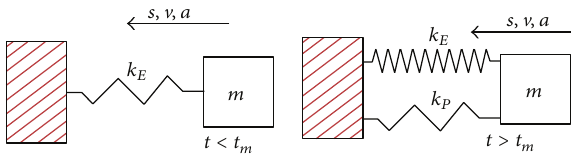
Figure 2: A spring-mass model.